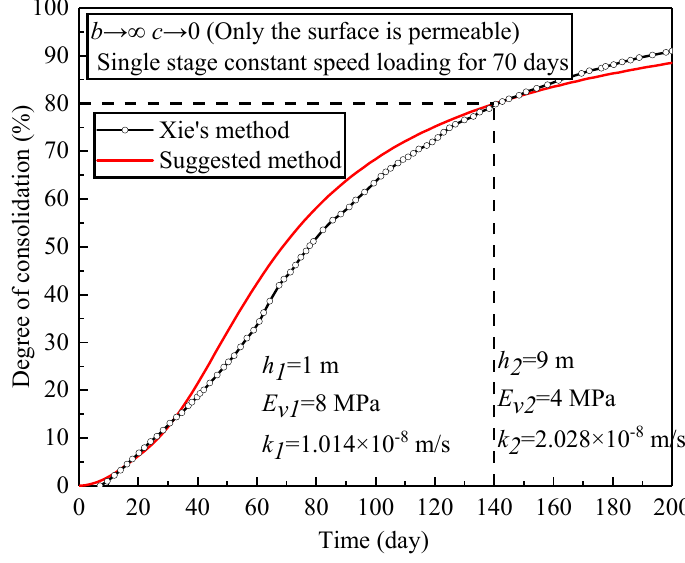
Figure 3. Consolidation curve for single-stage constant-speed loading.